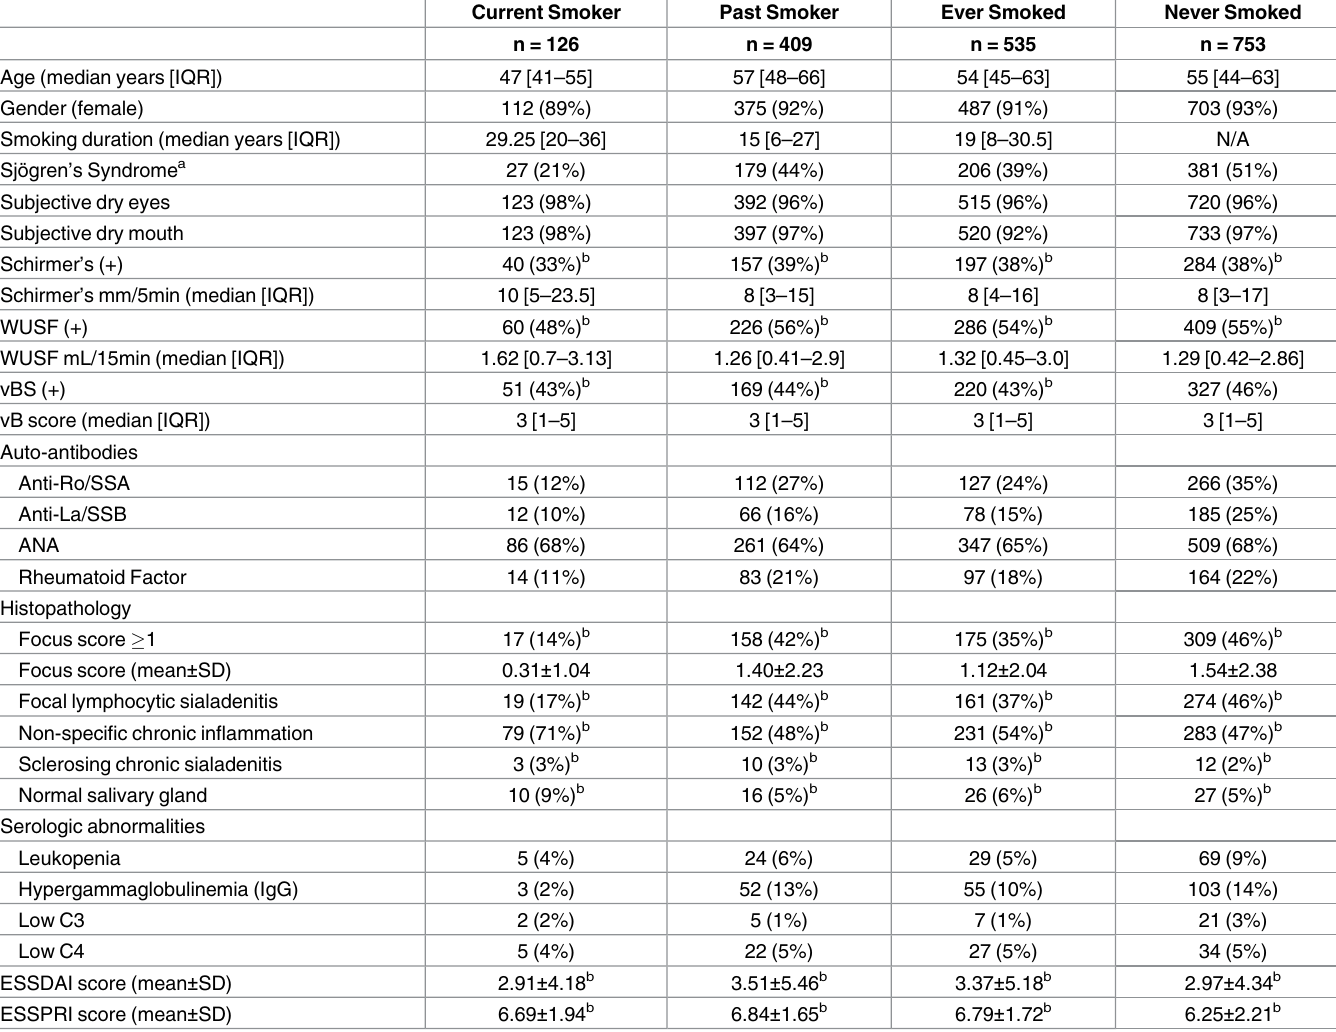
Table 2. Sociodemographic, clinical, and serological featuresof all study participants (irrespective of Sjo¨gren’s classification) based on smoking status. Current